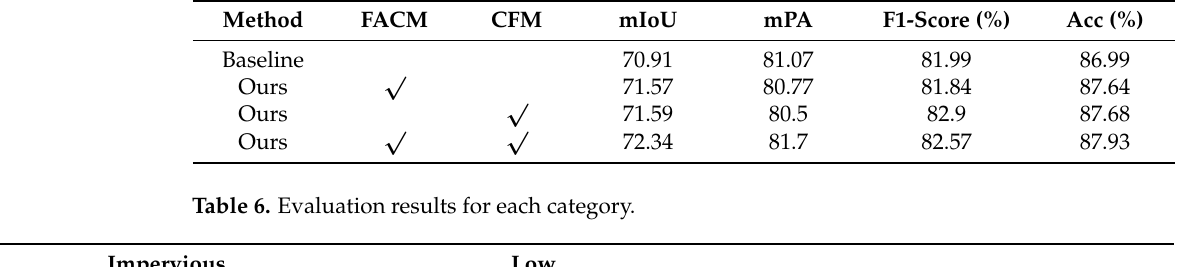
Table 5. The effects of different components of our method on the results.